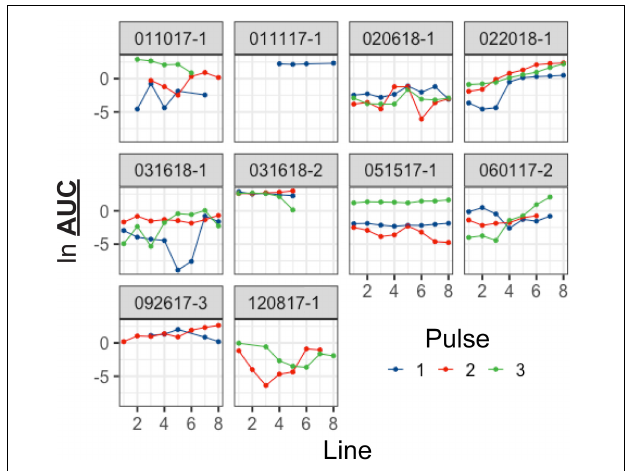
FIGURE 9 | Visual exploration of responders and non-responders. Arteriole responses (ln-transformed AUC) are plotted for each individual arteriole in response to 100 µ M L-THA. The responses at each individual arteriole segment (lines) are represented as points. Each graph represents data obtained from an individual animal and the effects of different pulses are shown in different colors. Note two animals are not presented. On the Ln scale, the mean response is –0.55 (95% CI –1.25 to